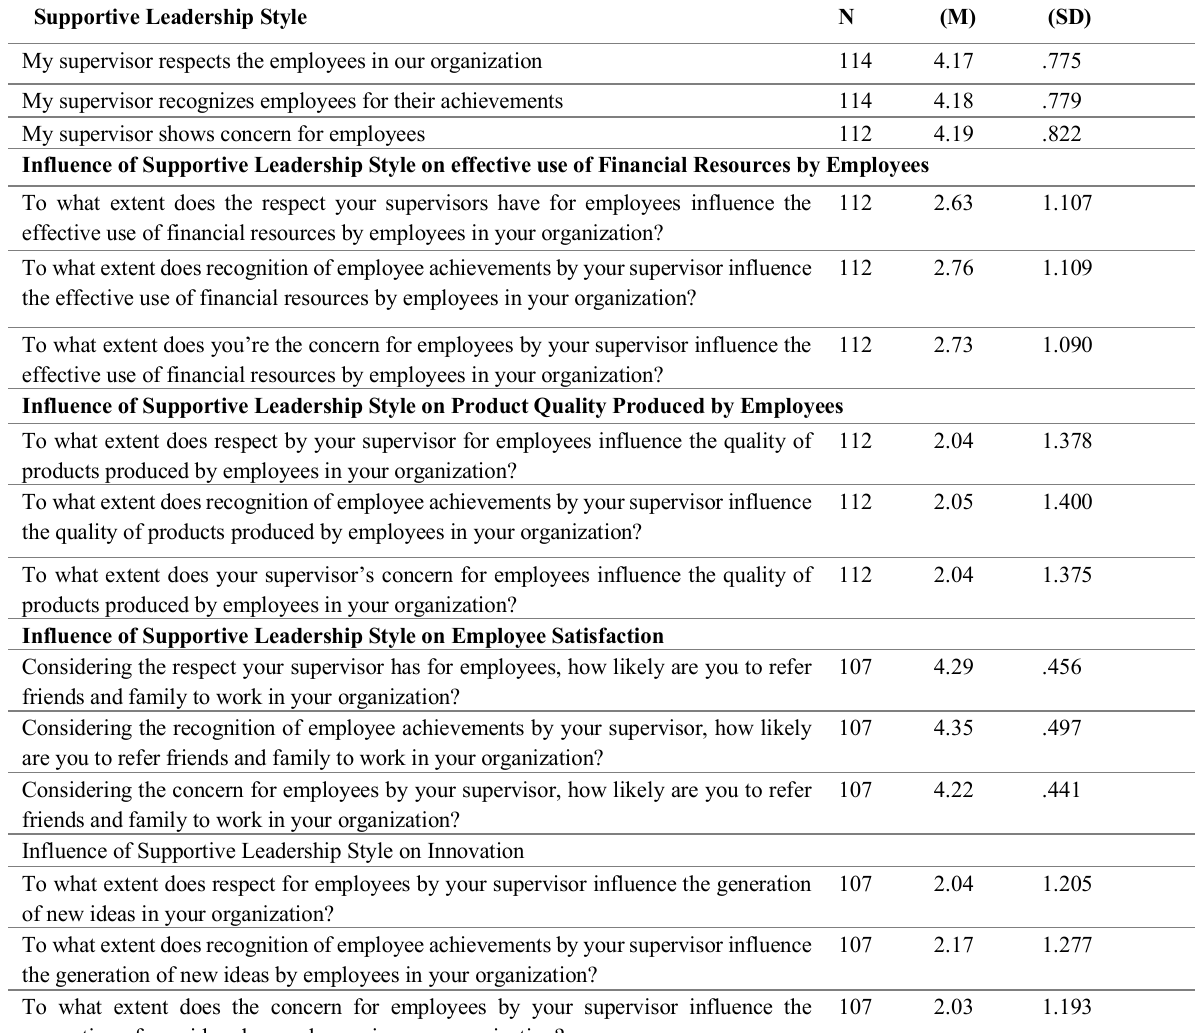
Table 1 : Mean and standard deviation for supportive